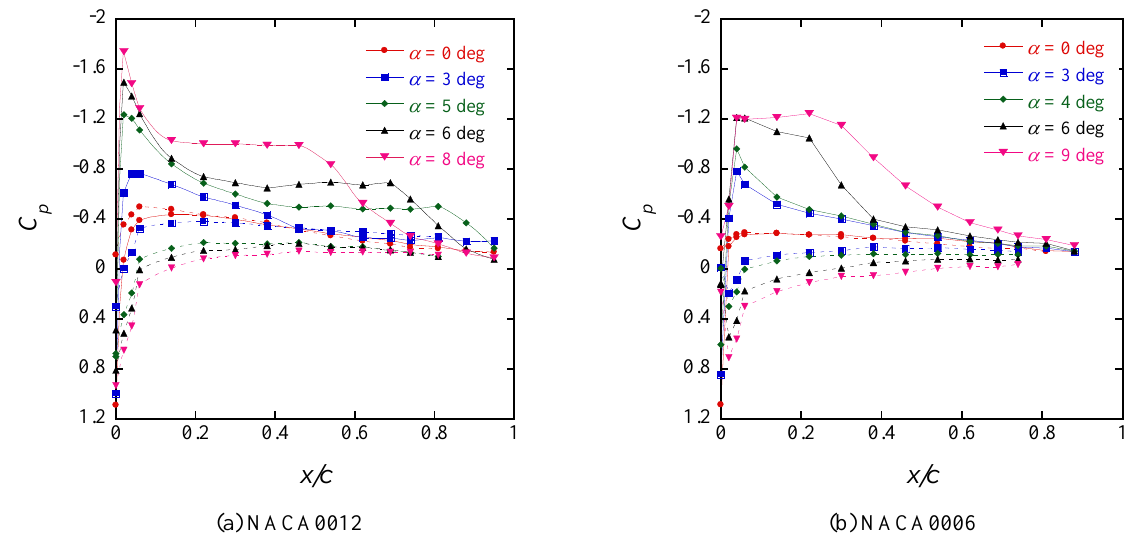
Fig. 6 Surface pressure distributions of NACA0012 and NACA0006 at Re = 20,000. Solid line indicates upper-surface pressure distribution and dashed line indicates lower-surface pressure distribution. A laminar separation bubble with a constant pressure region forms at  = 6 deg both for NACA0012 and NACA0006.